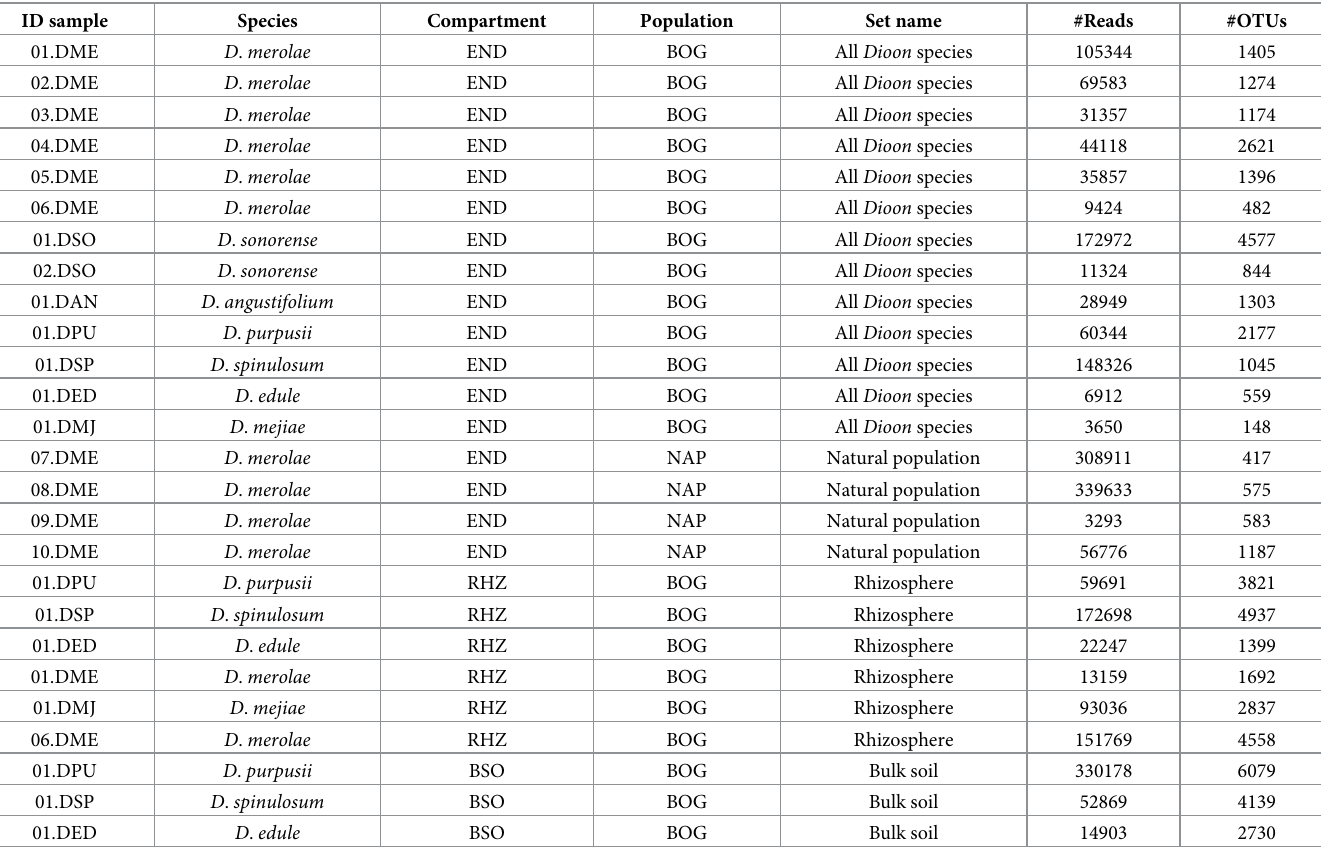
Table 1. Dioon samples of different species, compartments, populations, and sets; The number of reads and OTUs obtained for each individual are also shown. ID